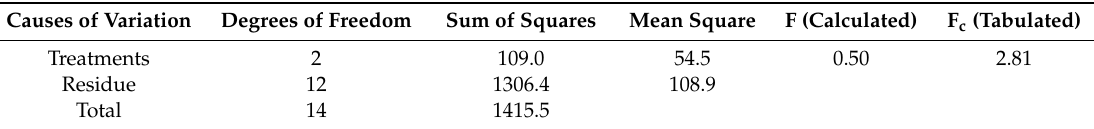
Table 11. Analysis of variance for the absorbed energy in the ballistic test of the CM sedge fiber-reinforced